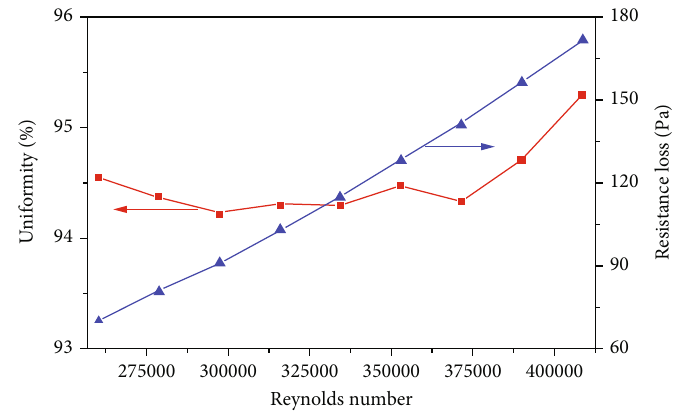
Figure 16: In fl uence of mixed gas fl ow change on fl ow